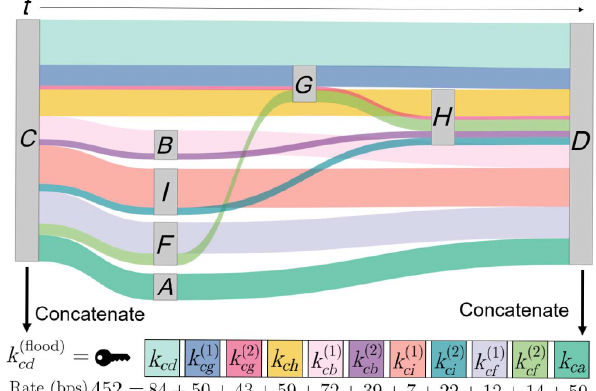
FIG. 8. The optimum end-to-end key flooding protocol between end users C and D on our eight-user quantum network test bed. The figure demonstrates an optimal flooding protocol between users C and D corresponding to the data used in Fig. 7. For clarity, the public announcements made by the intermedi- ary users are suppressed and shown instead in Sec. B 3 of the Appendix. The width of the bars indicates the length of the keys ultimately shared between C and D . The end users privately con- with length equal catenate the shared keys to produce k ( flood ) cd to the sum of the lengths of the shared keys. This achieves the optimal flooding rate shown in Fig.